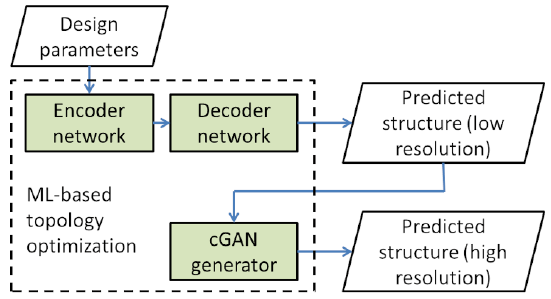
Figure 8. Machine learning (ML)-based topology optimization consisting of encoder / decoder networks and a conditional generative adversarial network (cGAN) generator proposed .